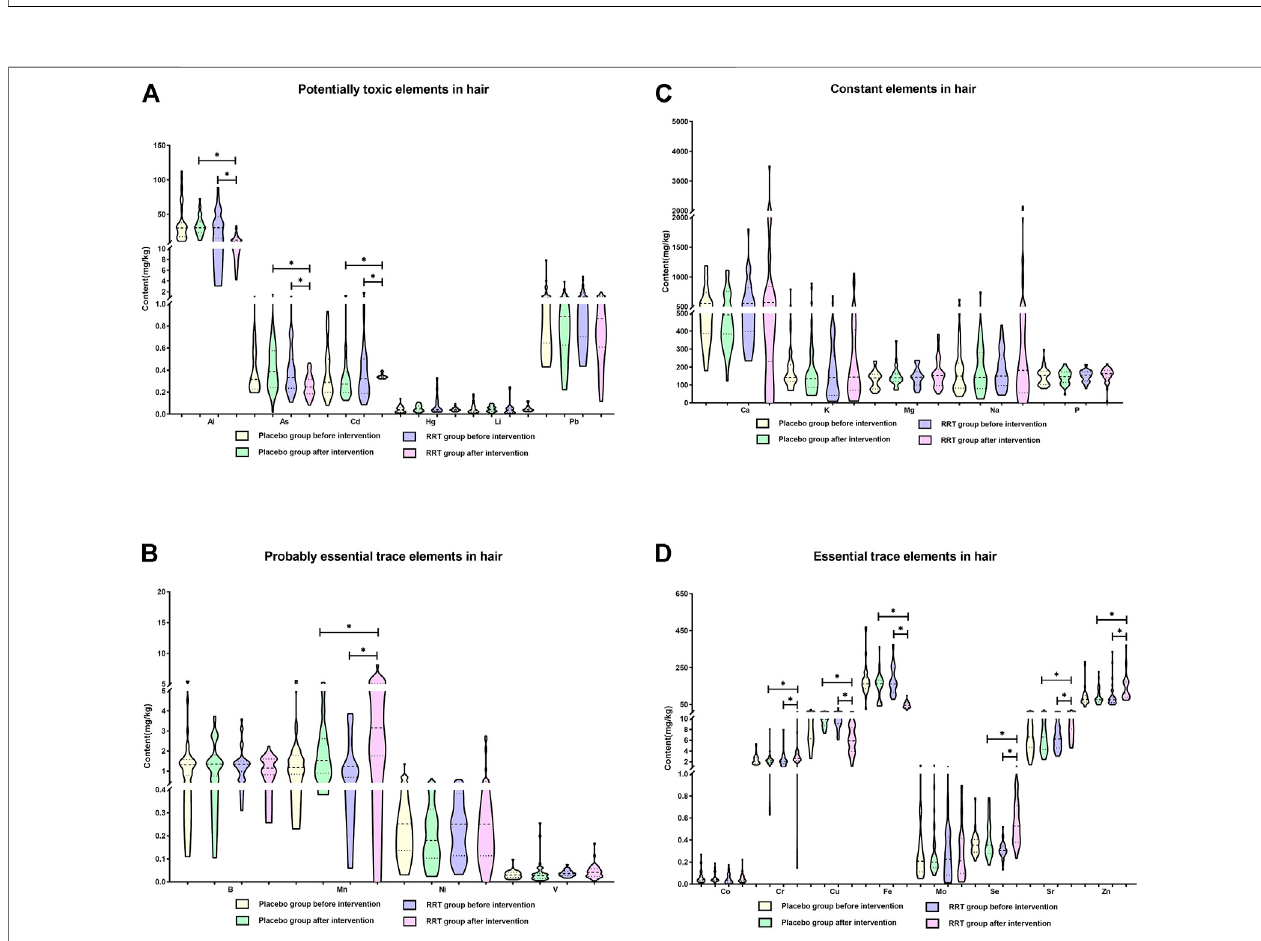
FIGURE 5 | Potential application value of RRT on the element imbalances in the population with arsenism. In this study, the median and interquartile range were expressed intheresults,* p < 0.05. (A) Thechangesinthecontentofpotentiallytoxicelements. (B) Thechangesinthecontentofconstantelements. (C) Thechangesin the content of probably essential trace elements. (D) The changes in the content of essential trace elements.